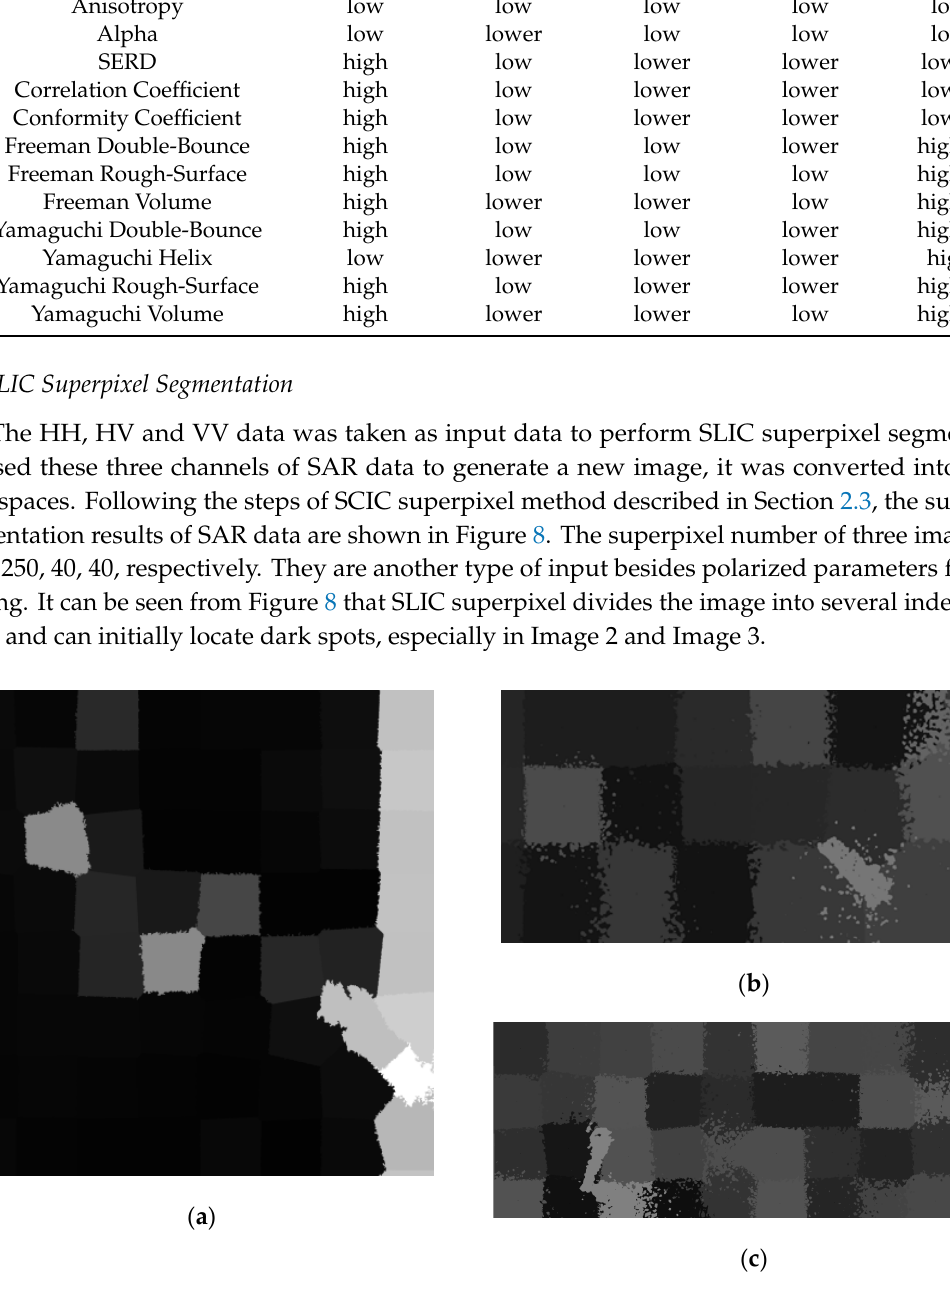
Figure 8. Simple Linear Iterative Clustering (SLIC) superpixel segmentation results. ( a ) Image 1, ( b ) Image 2 and ( c ) Image 3.